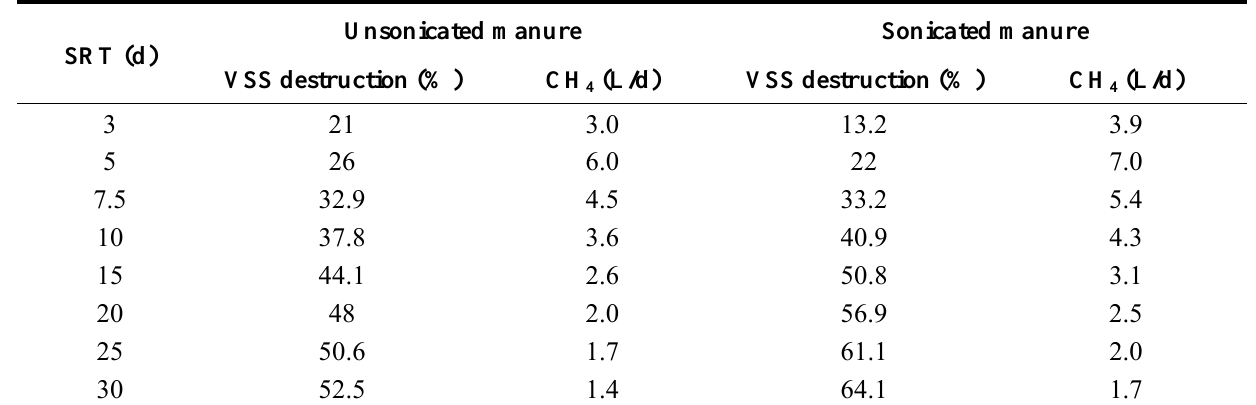
Table 3. VSS destruction and methane production at different SRTs using BioWin software.